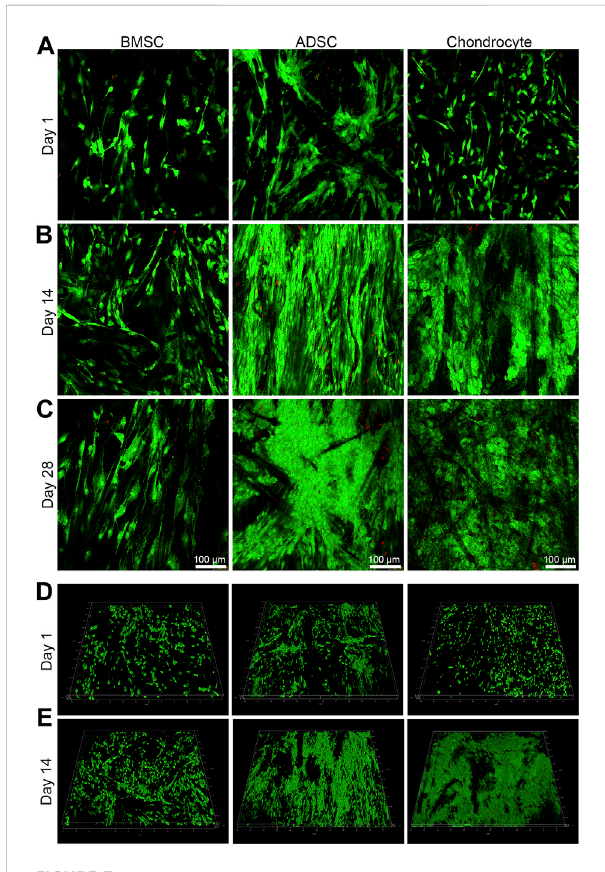
FIGURE 3 Cell viability and distribution on scaffolds. Live/dead staining demonstrates that cells are predominantly live with a spindle shape at day 1 (A) . BMSC and ADSC show increased numbers and maintain spindle shape and grow along fi ber direction, while chondrocyte undergoes signi fi cant morphology change into round shape from day 14 up to day 28 (B, C) . Reconstructed images illustrate that cells experience three-dimensional growth pattern on electrospun yarn scaffolds (D, E)